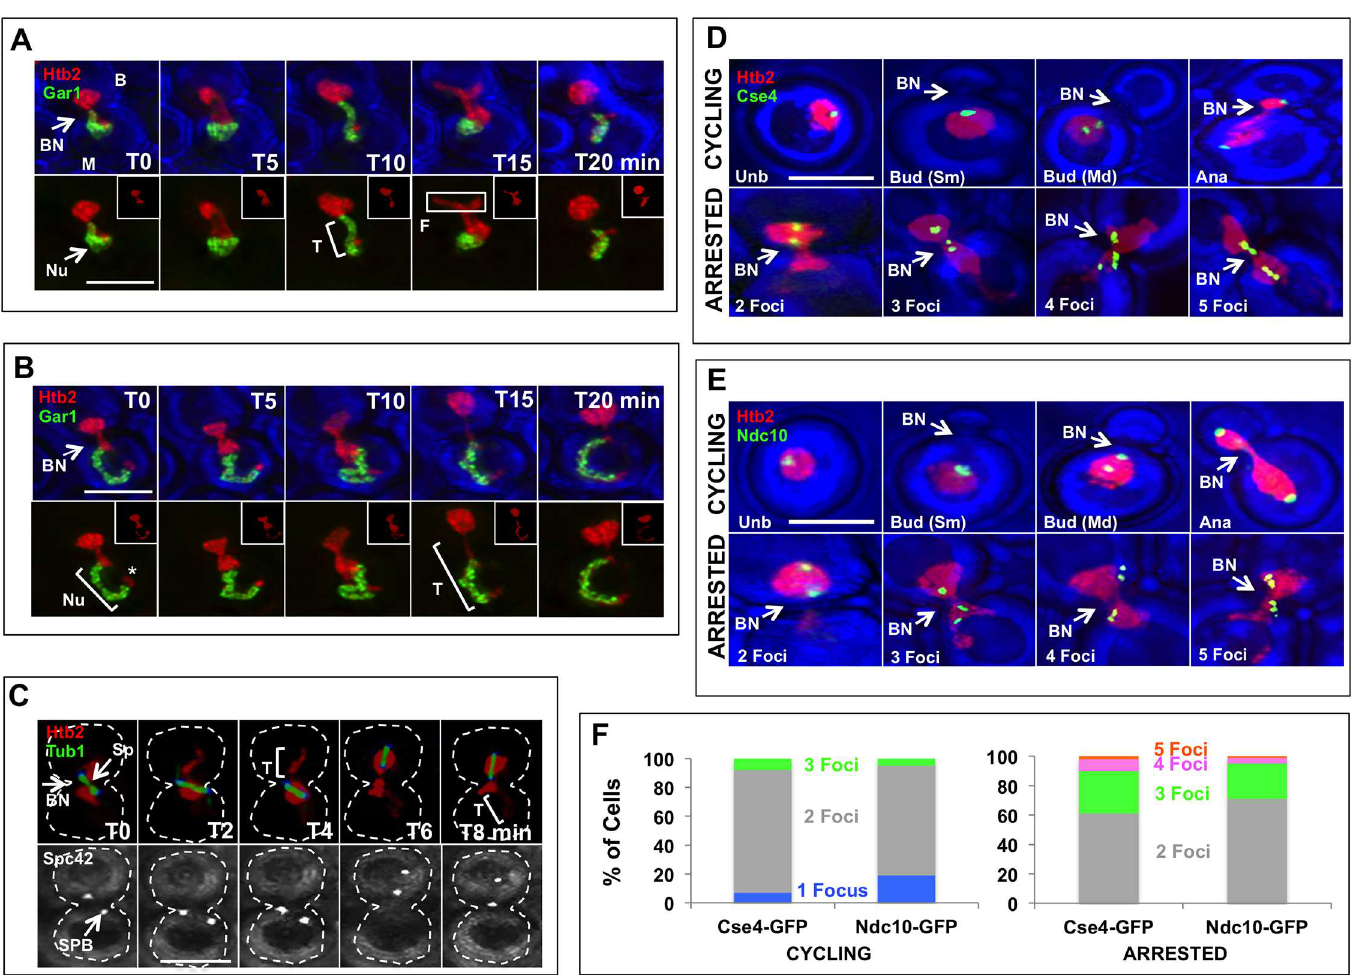
Fig 2. Dynamicsof Chromatin and the Nucleolus in ArrestedCells. (A) Time-lapse images of chromatinand the nucleolus. A MET3-CDC20 strain expressingthe taggedhistone, Htb2-mRFP, and the tagged nucleolarprotein, Gar1-GFP, was arrested by additionof methionine for 4 hours before imaging. Note that the chromatinmass (red) shifted betweenthe mother (M) and bud (B) domainsrepeatedlyand changedshapein doing so. When most of the chromatinwas in the bud domain,a narrow tail (T) extendedacross the mother domain.When the chromatinwas retracting from the bud domain, the trailing edge often had a flattened surface (F) (rectangle).The nucleolus (Nu—green) alwaysremainedin the mother domain.In the inserts, the green signal is absent so that the red can be more uniformly detected. The blue images are bright-field. Strain: ATY3175.(B) As in Fig 2A except that the nucleolusand chromatinin the mother domain were further extended. In this situation, the tail in the mother domain defineda narrow ribbonthat ends in a red patch ( * ) at its extremity. Strain: ATY3175. (C) Time-lapse images of chromatin, the spindleand the spindlepole body. A MET3-CDC20 strain expressingHtb2-mRFP, Tub1-GFP and the SPB protein, Spc42-CFP, was arrested by additionof methioninefor 4 hours and then imaged.The orientationof the spindle(Sp) shifted and the entire spindlefrequently moved from one domain to the other along with chromatin. As shown in the lower images, the SPBs (arrow) remained associatedwith both extremitiesof the spindle. Strain: ATY7135. (D-E) Localization of centromeres (D) and kinetochores (E). The tagged variant histone, Cse4-GFP, and the taggedkinetochoreprotein, Ndc10-GFP, were localizedin cycling cells (upper panels) and in a MET3-CDC20 strain after arrest for 4 hours by additionof methionine (lower panels). Cyclingcells: In most unbuddedcells (Unb), both Cse4-GFP and Ndc10-GFP formed singleclusters, while they had doubledin cells with small buds (Sm) or medium-sized buds (Md) and in cells in anaphase(Ana). Arrested cells: Note the frequent presenceof additionalfluorescent foci (fragments) for both Cse4-GFP and Ndc10-GFP. Both cells expressingCse4-GFP with the tag at an internalpositionand cells with the tag at the C-terminus exhibitedcomparablefragmentation. Strains: ATY6196, ATY6882, ATY6833. (F) Quantitationof the number of foci detected in preparations equivalent to Fig 2D and 2E. Strains: ATY6196 and ATY6882.